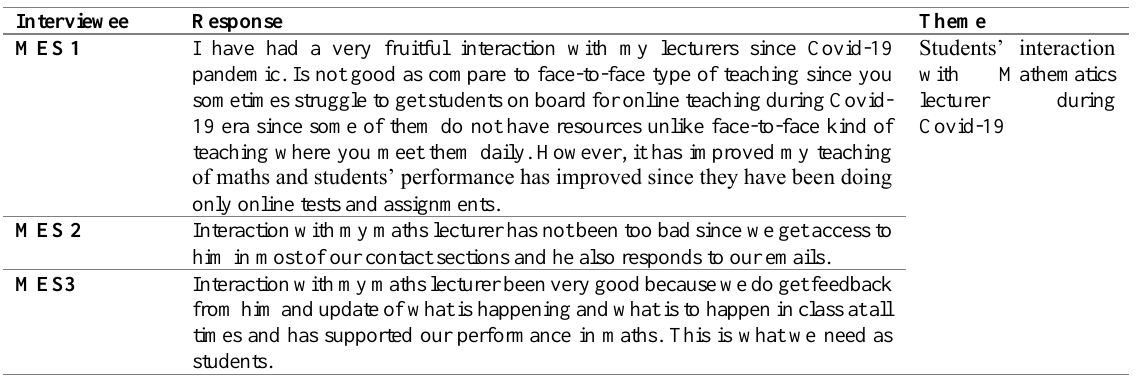
Table 9: Question 9 - How would you describe your interaction with your Mathematics lecturer(s) during Covid-19 and how has it influenced your learning of Mathematics and performance? Interviewee